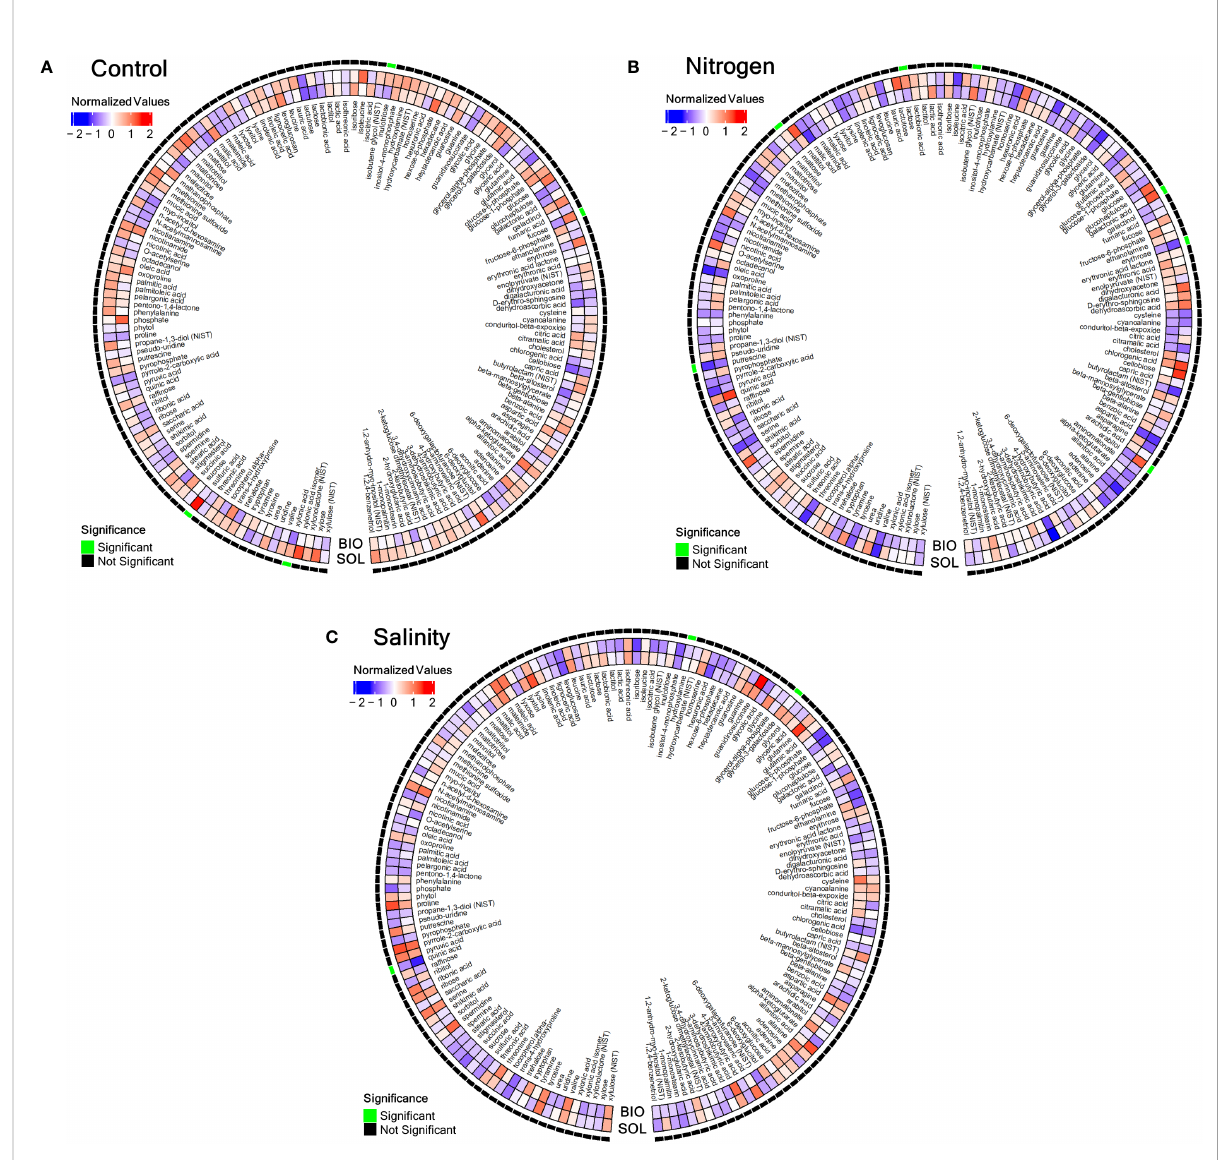
FIGURE 3 Metabolomic comparison between solarized and biosolarized pre-treated (A) control-treated plants, (B) nitrogen-deprived plants, (C) salinity- treated plants. A heatmap comparing the standardized averages of metabolite counts in salinity-treated solarized (SOL) and biosolarized (BIO) plants (n=5). Each metabolite value was standardized as the standard deviation from the average metabolite value of all plants (n=30), and the values were averaged for solarized and biosolarized treatments and were shown in the red-white-blue scale (blue denotes low values and red denotes high values), while signi fi cance (p<=0.05) was tested between the two groups (n=5) using the permuted Brunner Munzel test (signi fi cance was denoted by an outer green box, while insigni fi cance was denoted by an outer black box).